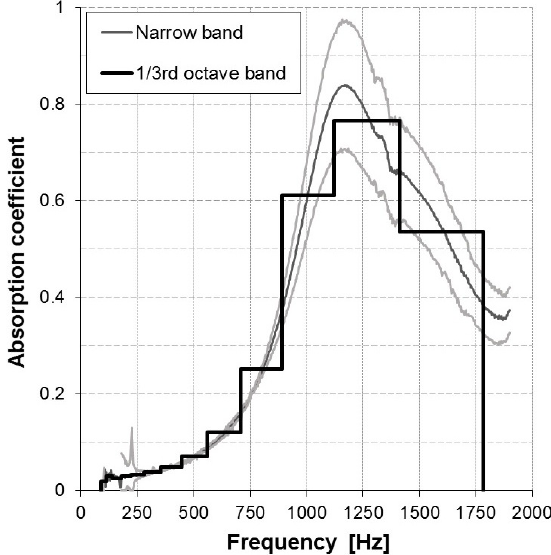
Figure 2. Site 1: Absorbing coefficient vs. frequency measured using impedance tube on some samples extracted from the surface. In grey the dispersion of data from narrow band analysis and in black the resulting 1/3rd octave band result. The main absorption peak can be found at about 1100